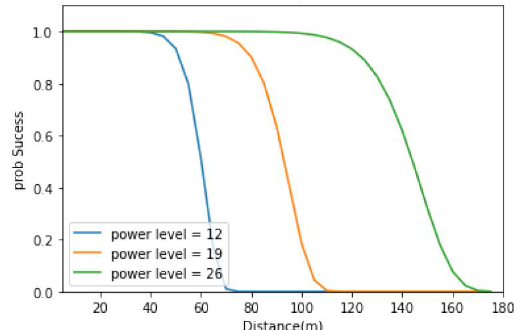
Figure 5. Probability Experience of Different Power Level and Distance Between Sensor